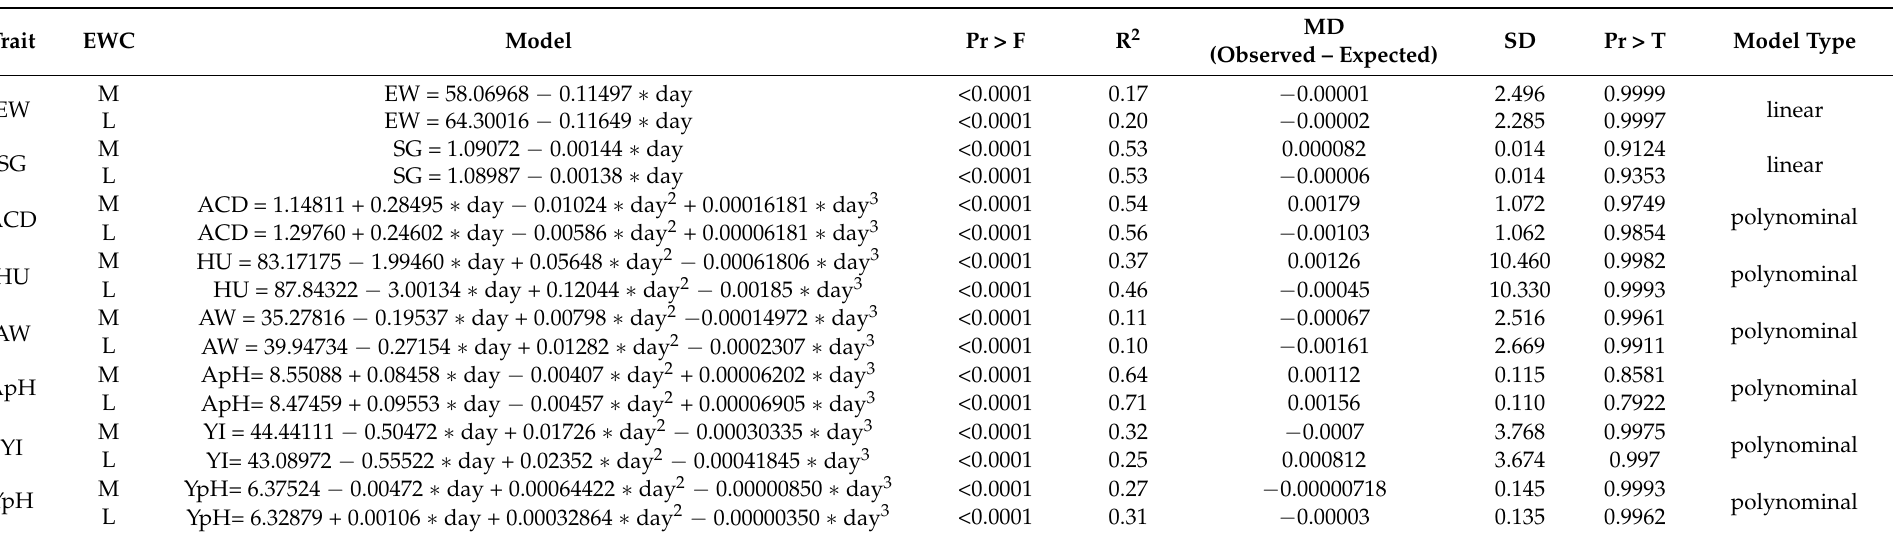
Table 2. Statistical models used for particular trait